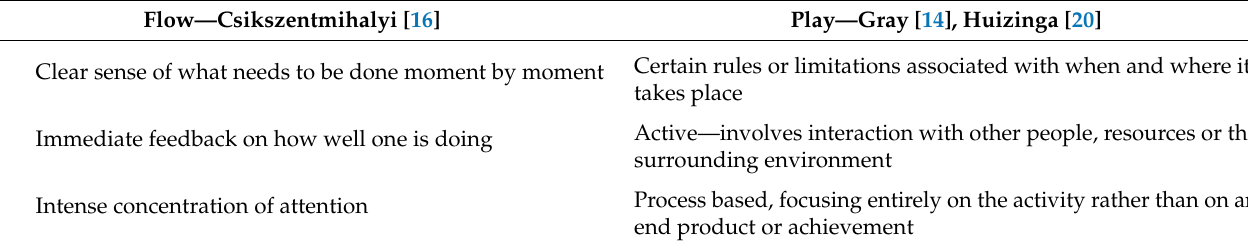
Table 1. Shared characteristics of a state of flow and